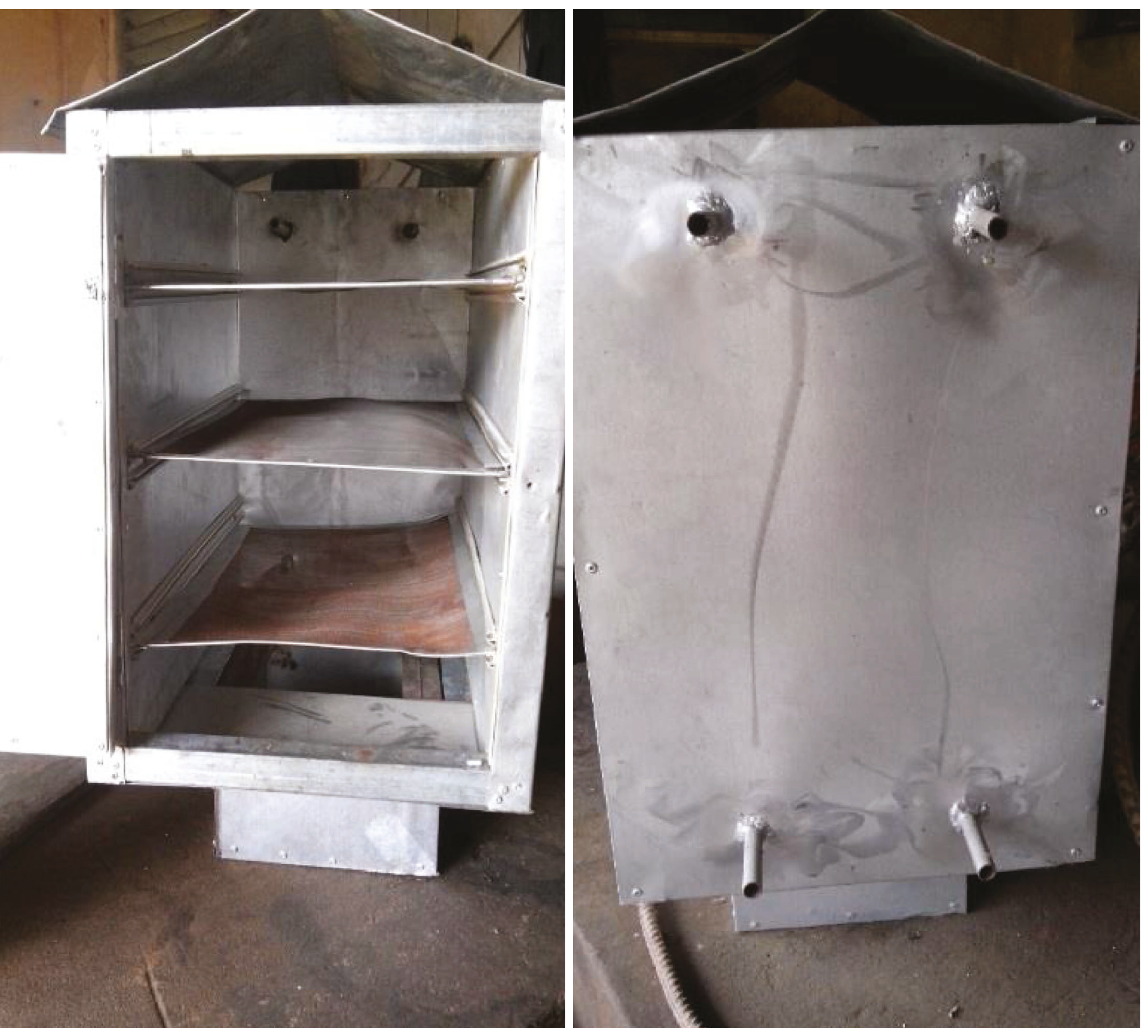
Figure 3: Front and rear views of manufactured smoke filter unit.